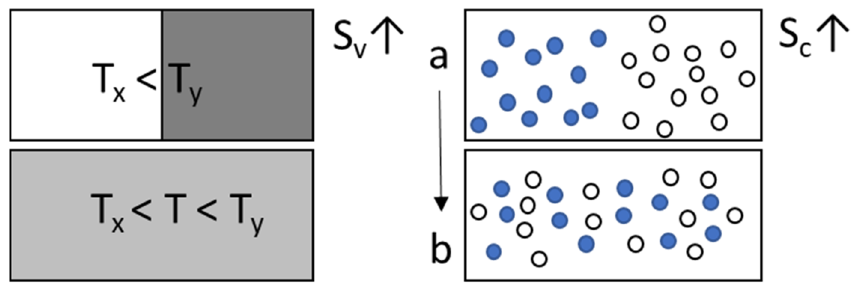
Figure 6. Increase in vibrational entropy between two systems at temperatures T x and T y as a function of temperature [S v = f (T)] and configurational entropy as a function of distribution states from unmixed (a) to mixed (b) state [S c = f (ln W)] (Adapted with permission from [57] Gaskell et al., Introduction to the Thermodynamics of Materials, published by Taylor & Francis Group, 2017).